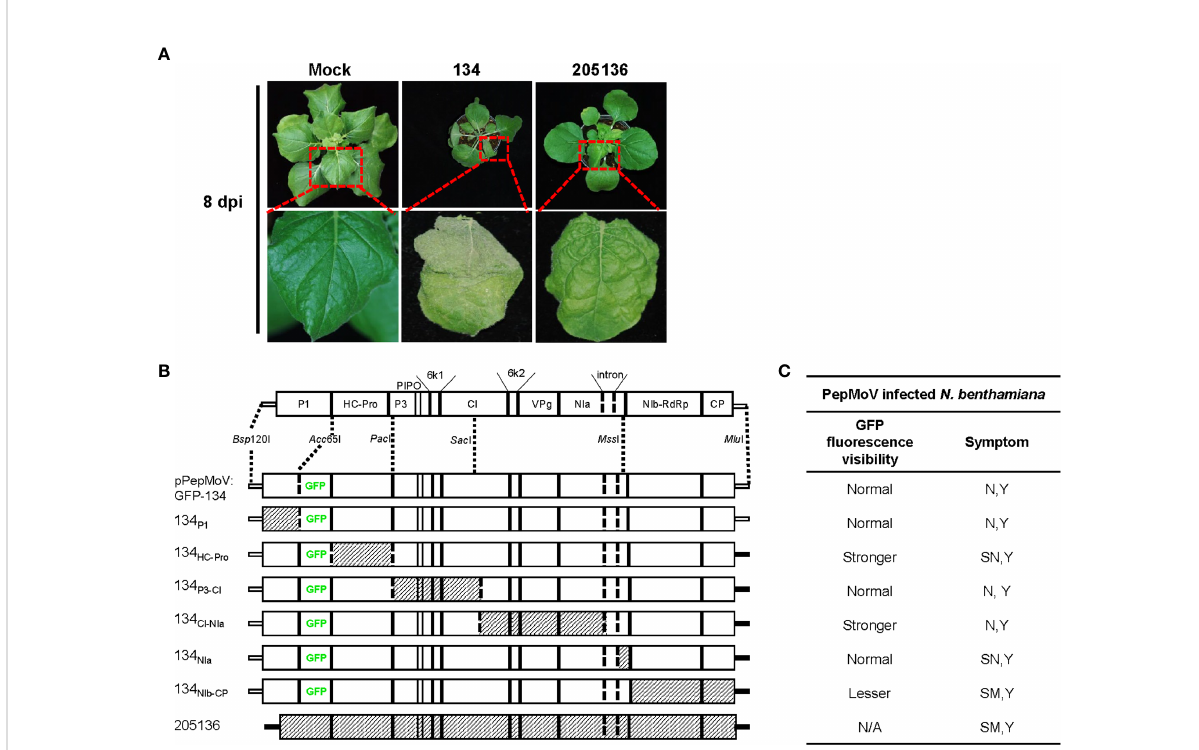
FIGURE 1 (A) Symptoms on N. benthamiana leaves infected with pepper mottle virus (PepMoV) isolates 134 and 205136. Results from upper systemic (non-inoculated) leave at 8 days post-inoculation (dpi) are shown. (B) Schematic representation of chimeric mutants of PepMoV isolates 134 and 205136. Chimeric mutants were constructed by substituting counterparts between 134 and 205136. pPepMoV : GFP-134 and 205136- derived regions are indicated by blank and hatched boxes, respectively. (C) Summary of 134 mutants shown in Figures 2 and 3. GFP fl uorescence representing virus infection and symptoms of the other six chimeric viruses were compared with PepMoV isolate134. Viral accumulation was observed at 5 and 8 dpi, and symptom development was detected at 12 dpi. N, necrosis; Y, yellowing; SN, severe necrosis; SM, severe mottle; N/A, not